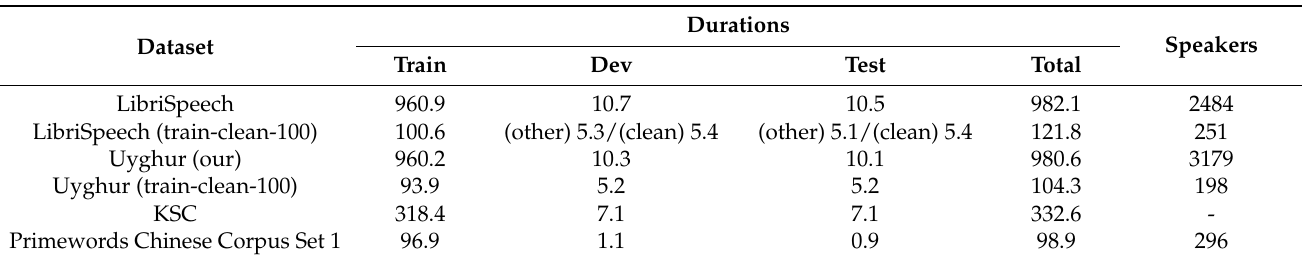
Table 1. Specifications of the LibriSpeech, Primewords Chinese Corpus Set 1, Uyghur (our), and KSC corpus